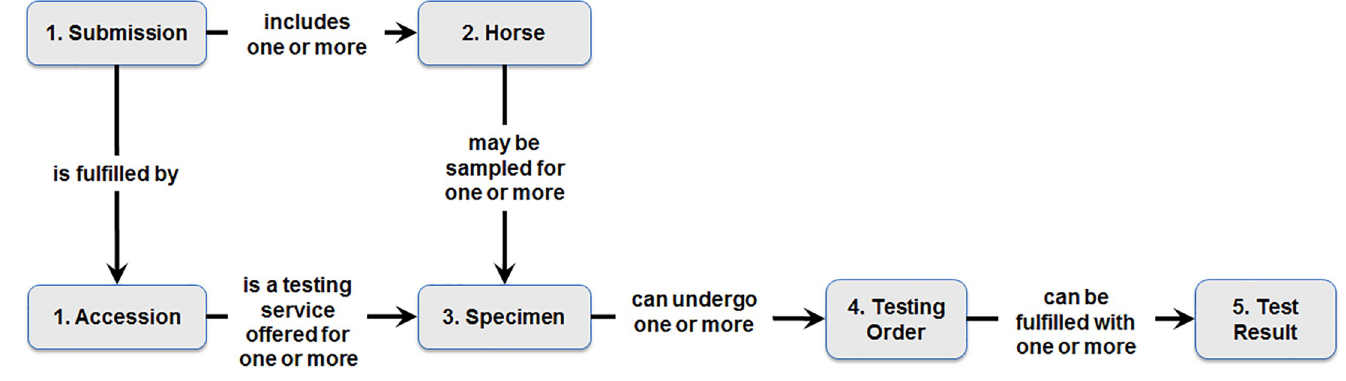
Fig 1. Formation of veterinary laboratory